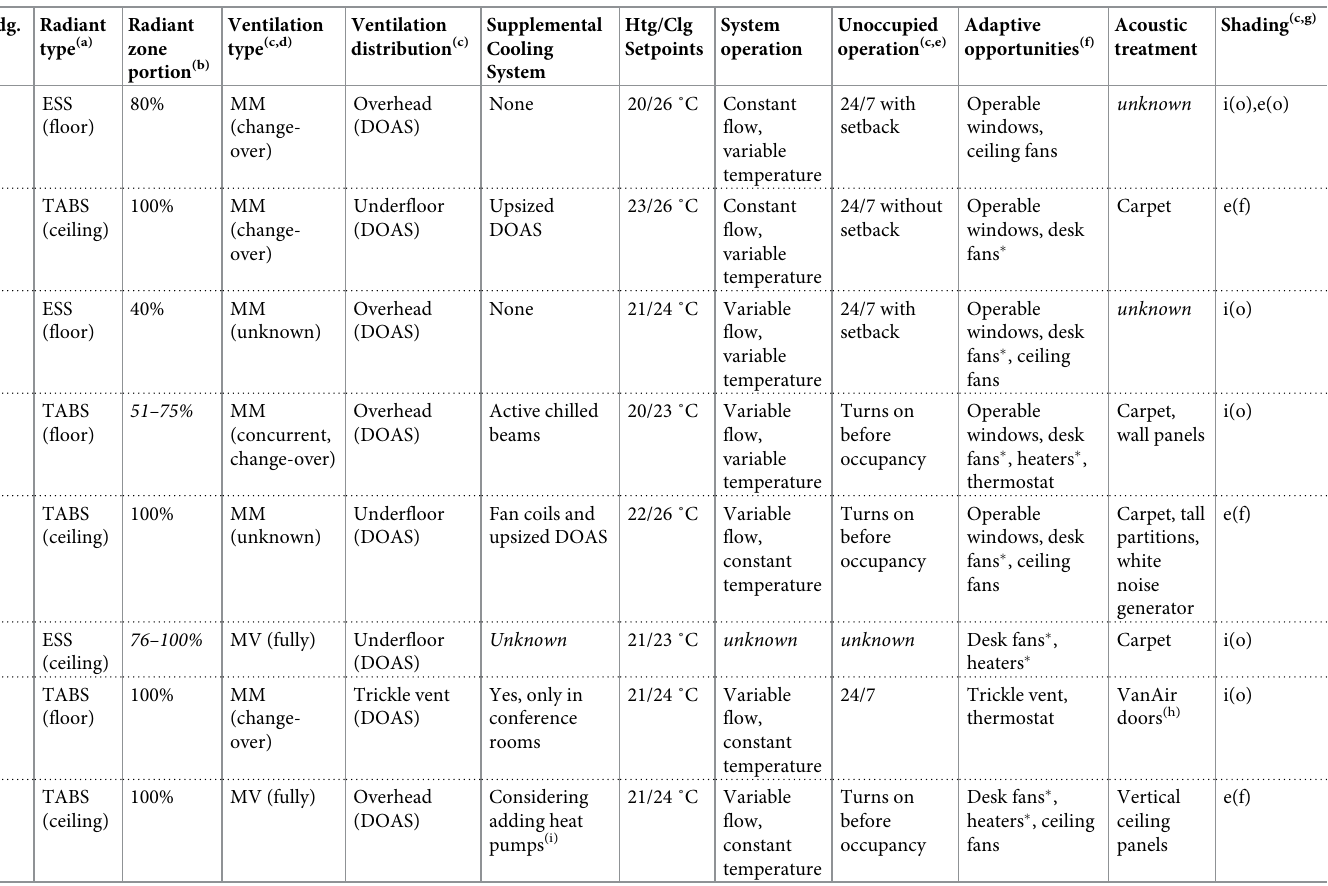
Table 2. Comfort and energy concept of the building. Bldg.